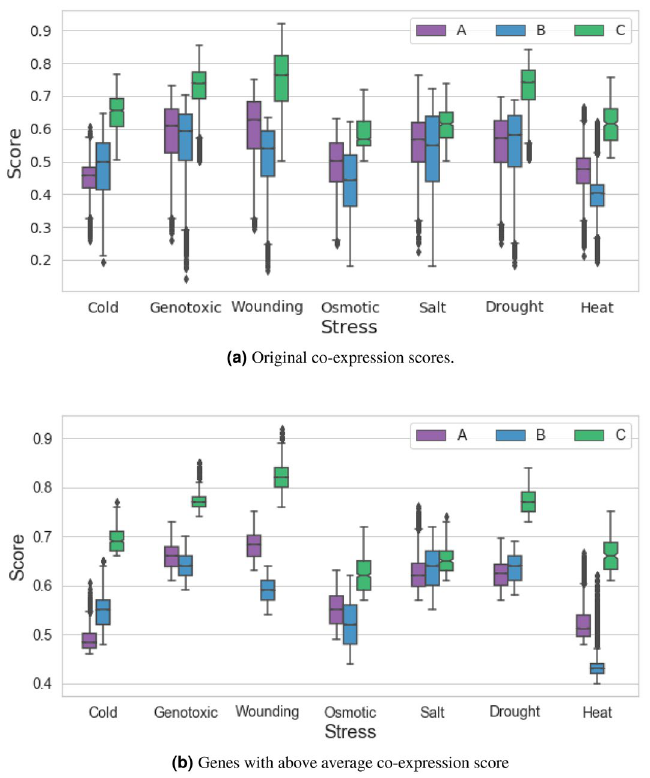
Figure 9. Co-expression correlation distribution of genes in A, B, and C subunits across all